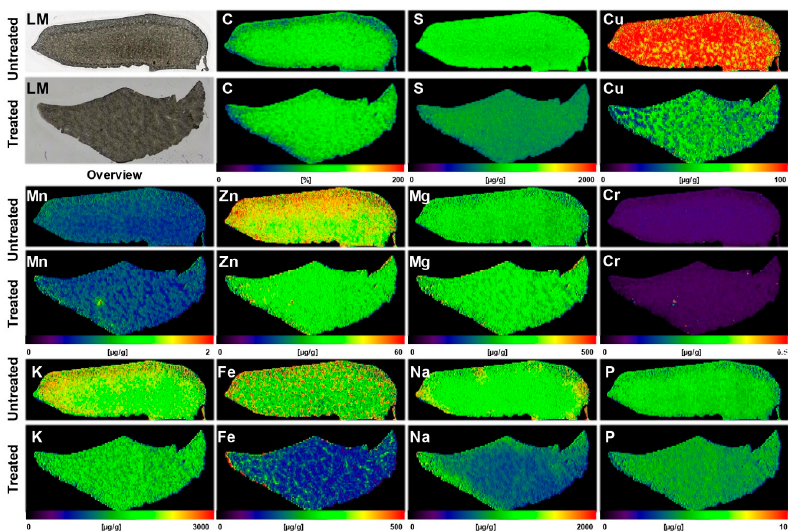
Figure 7. Gene therapy in Atp7b null mice reverses hepatic Cu overload. The content of carbon (C), sulfur (S), copper (Cu), manganese (Mn), zinc (Zn), magnesium (Mg), chromium (Cr), potassium (K), iron (Fe), sodium (Na), and phosphorus (P) was determined by LA-ICP-MSI in 30-µm-thick liver cryosections of Atp7b null mice that received a therapeutic effective AAV virus expressing a therapeutically effective human ATP7B gene. Control samples were taken from untreated age-matched Atp7b null littermates. For orientation, light microscopic (LM) images of respective cryosections before subjecting to LA-ICP-MSI procedure are depicted. More details of this study are given elsewhere [43,49]. Inorganics 2019 , 7 , x FOR PEER REVIEW The beneficial effects to correct cerebral Cu overload by gene reconstitution were also recently confirmed by LA-ICP-MSI in brain sections of treated and untreated Atp7b − / − mice [44]. Animals that were sacrificed 14 weeks after therapeutic treatment with AAV-AAT- co -miATP7B showed a reduction of mean cerebral Cu content (3.05 ± 0.17 µg/g vs. 3.80 ± 0.2 µg/g) that was most prominently noticeable in the cerebellum, cerebellar white matter, corpus callosum, and 3 rd and 4 th ventricles when compared to the untreated littermates (Figure 8) [44]. In the brain of respective animals, other elements (Fe, Zn, Mn, Na, Mg, K, Ca, P, Cr, Ni, and Pb) were not affected, suggesting the transgene as an effective mean in specifically directing reduction of cerebral Cu [44].